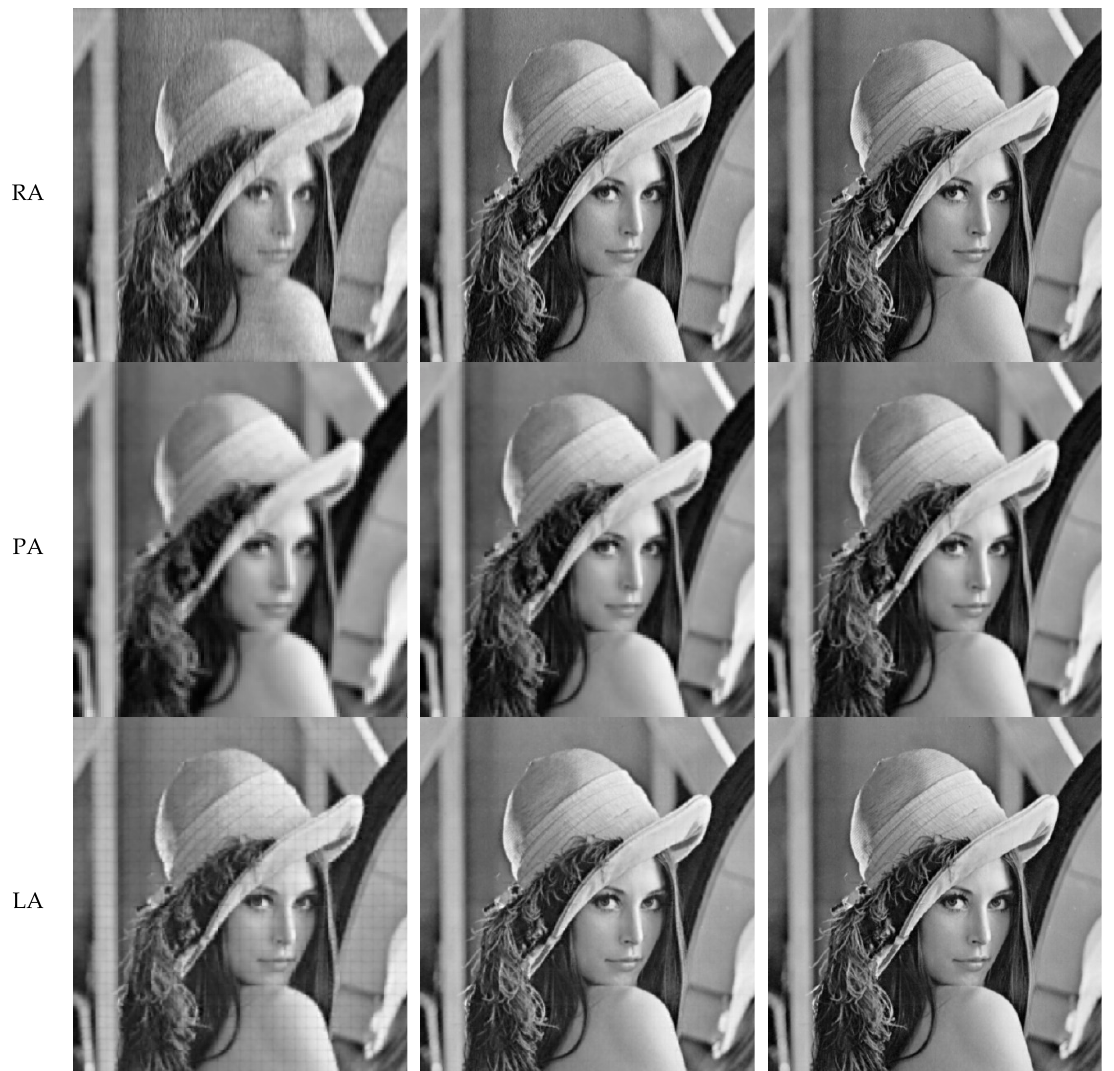
Figure 6. Visual quality comparison on test image Lenna for various measurement structures. Note: the block-size pair of LA is (8, 16).